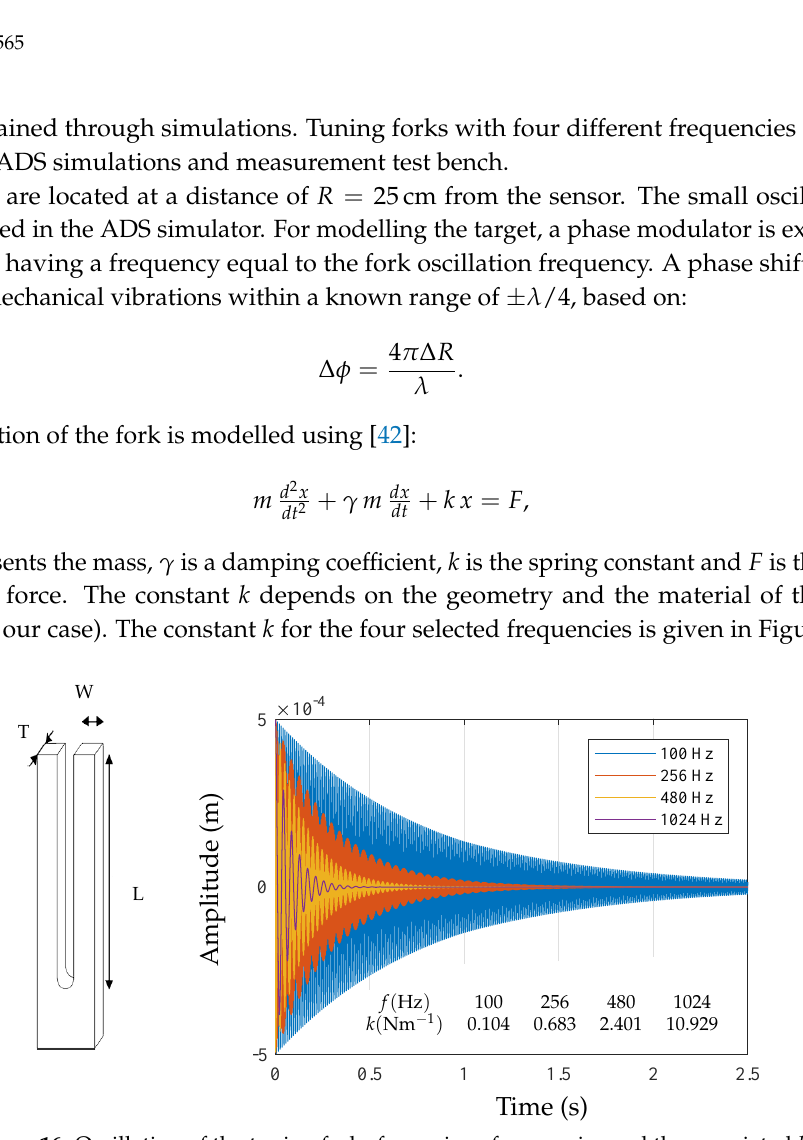
Figure 16. Oscillation of the tuning forks for various frequencies, and the associated k .